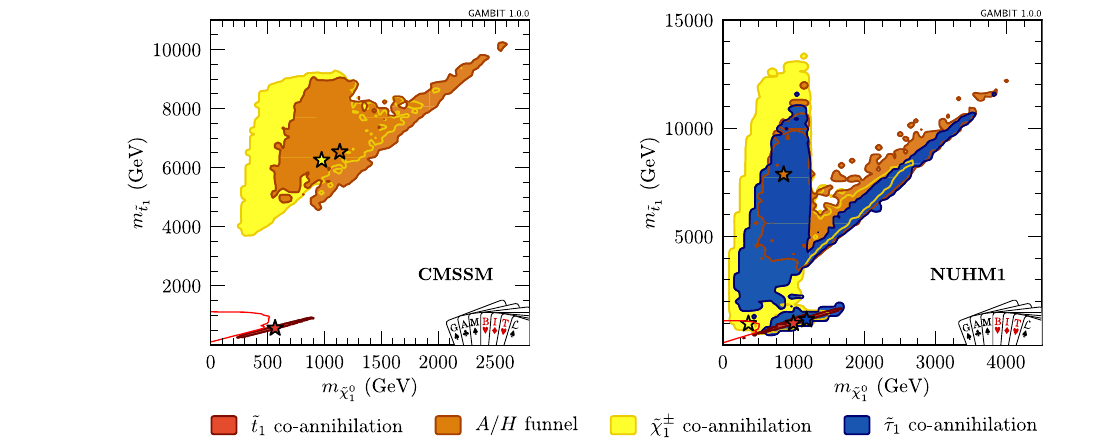
Fig. 14 2D profile likelihoods for the CMSSM, plotted in the ˜ t 1 − ˜ χ 0 mass plane. Left: the full range of neutralino masses present in the com- bined sample. Right: as per the lefthand panle, but zoomed in to focus on the low-mass region. Superimposed in red is the latest CMS Run